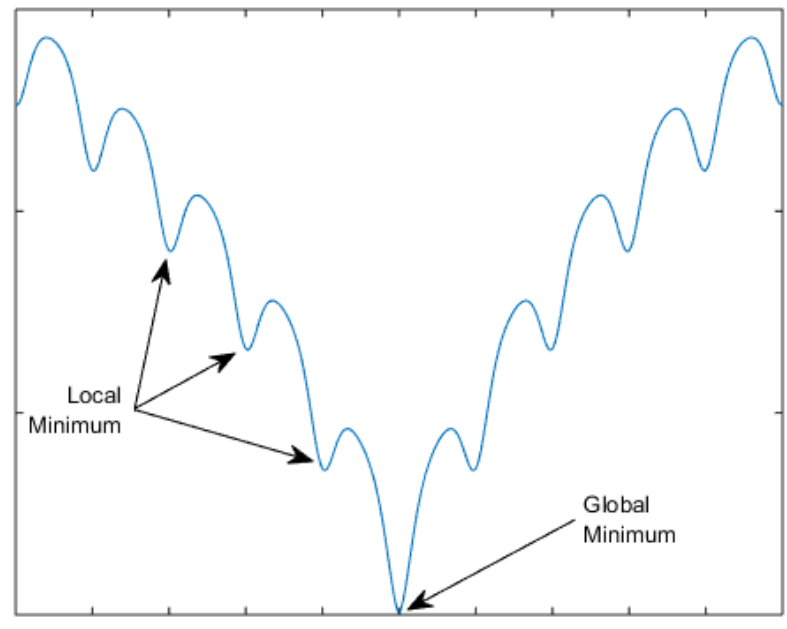
Figure 1. An example of local and global optimum points in function minimization.